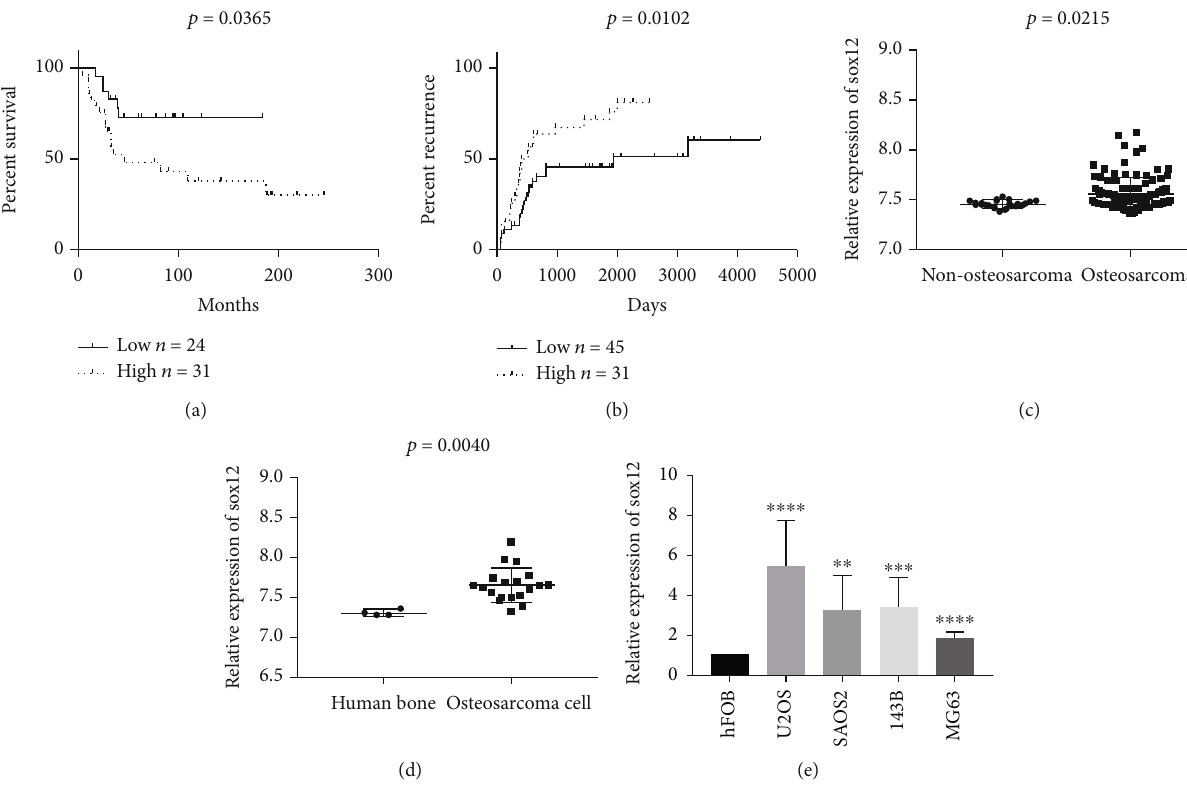
Figure 1: Clinical information for SOX12. (a) Kaplan – Meier survival curves of low and high SOX12 levels in the GSE21257 database. (b) Kaplan – Meier analyses reveal correlations between SOX12 expression and tumor recurrence in the TARGET database. (c) Relative expression of SOX12 in human bone and osteosarcoma cells in the GSE42352 database. (d) Relative expression of SOX12 in nonosteosarcoma and osteosarcoma in the GSE28424 database. (e) Relative mRNA expression of SOX12 in osteosarcoma cell lines compared to hFOB. ∗∗ p < 0 : 01 , ∗∗∗ p < 0 : 001 , ∗∗∗∗ p < 0 : 0001 . 3: Association between SOX12 expression and clinicopathological parameters in the TARGET database. SOX12 Parameters